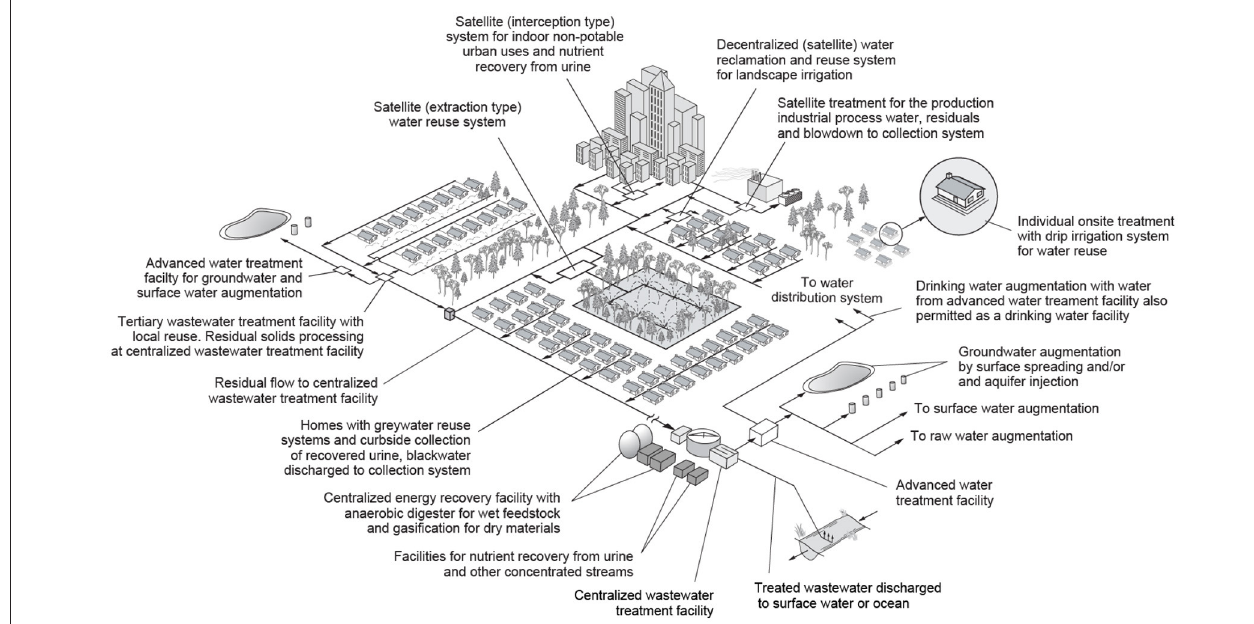
FIGURE 6 | Schematic view of an integrated wastewater management system (adapted from Gikas and Tchobanoglous,